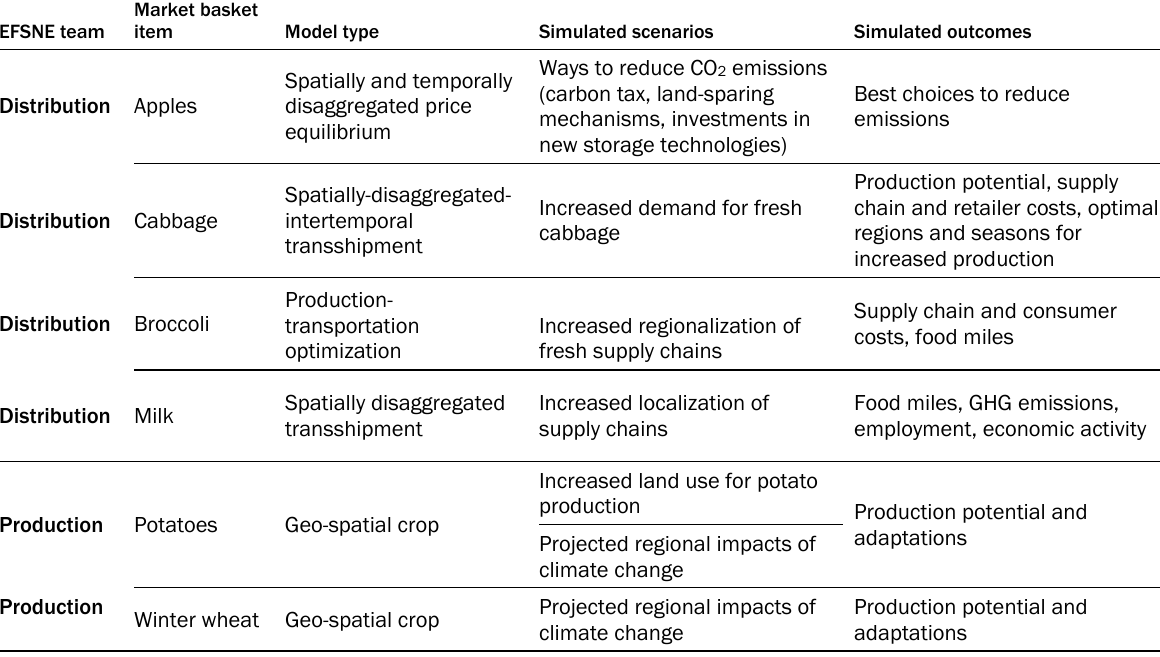
Table 6. Overview of Models Used to Explore Six Market Basket Items in Northeast